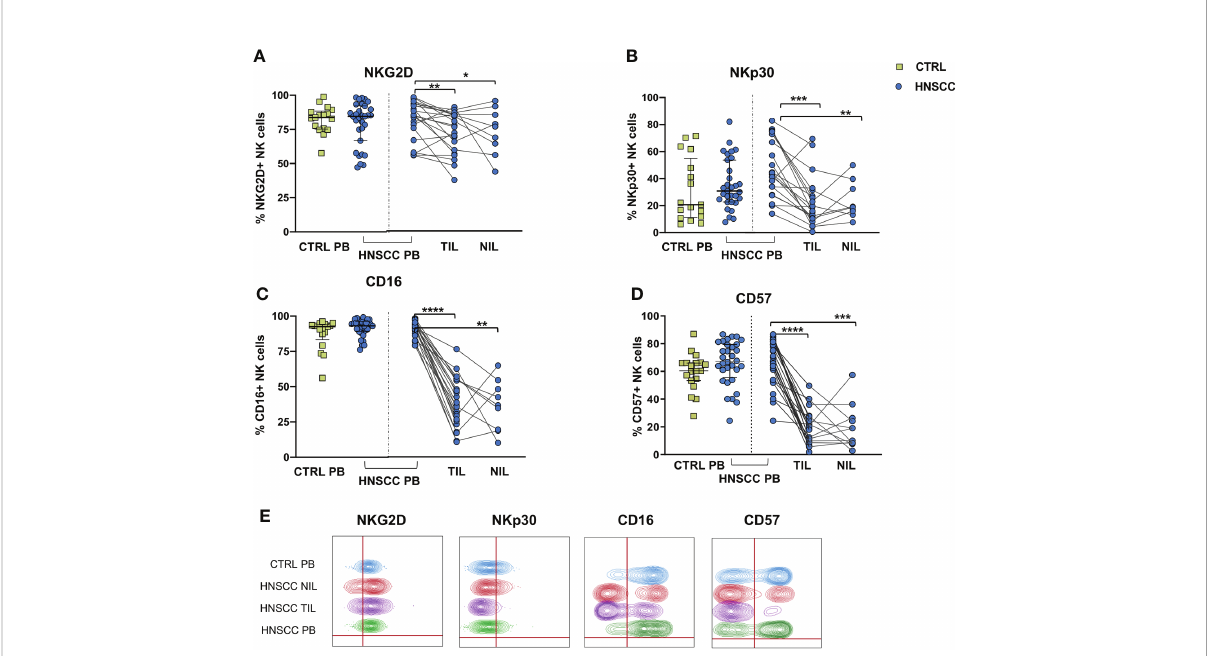
FIGURE 3 Frequences of NK cells expressing (A) NKG2D, (B) NKp30, (C) CD16 and (D) CD57 were determined in PBMC from control subjects (CTRL PB), and from HNSCC patients (HNSCC-PB) as well as matched tumor- (TIL) and surrounding non-tumor in fi ltrating lymphocytes (NIL). (E) Representative concatenated fl ow cytometry plots showing the percentage of expression of the indicated phenotypic markers on CD3 - CD56 + NK cells. The Mann – Whitney U test was used to compare CTRL and HNSCC subjects. Paired data were analyzed by the Wilcoxon signed rank test. *p < 0.05, **p < 0.01, ***p < 0.001, ****p <